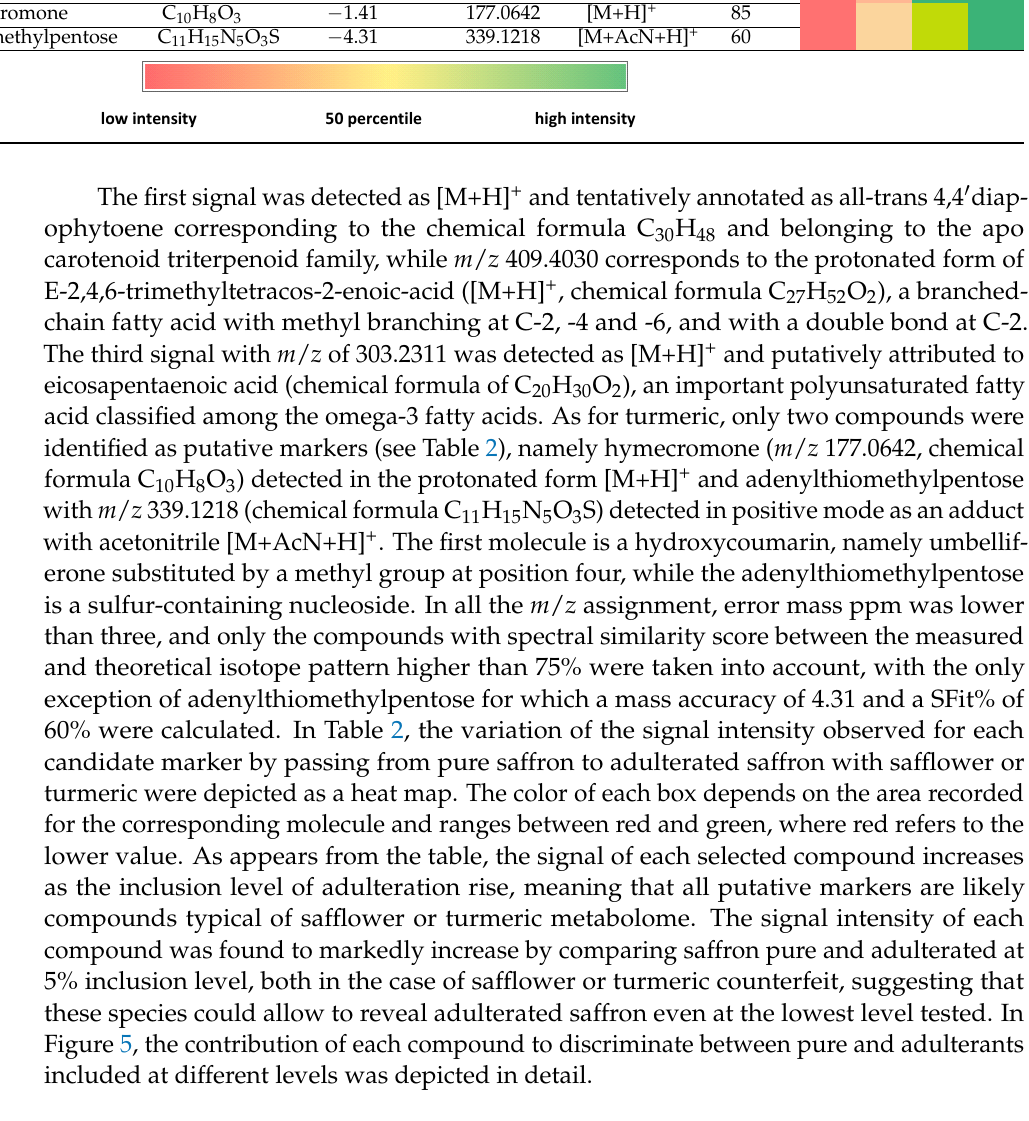
Table 2. Candidate marker compounds to discriminate between saffron pure and adulterated with safflower or turmeric at different inclusion levels (0, 5, 10 and